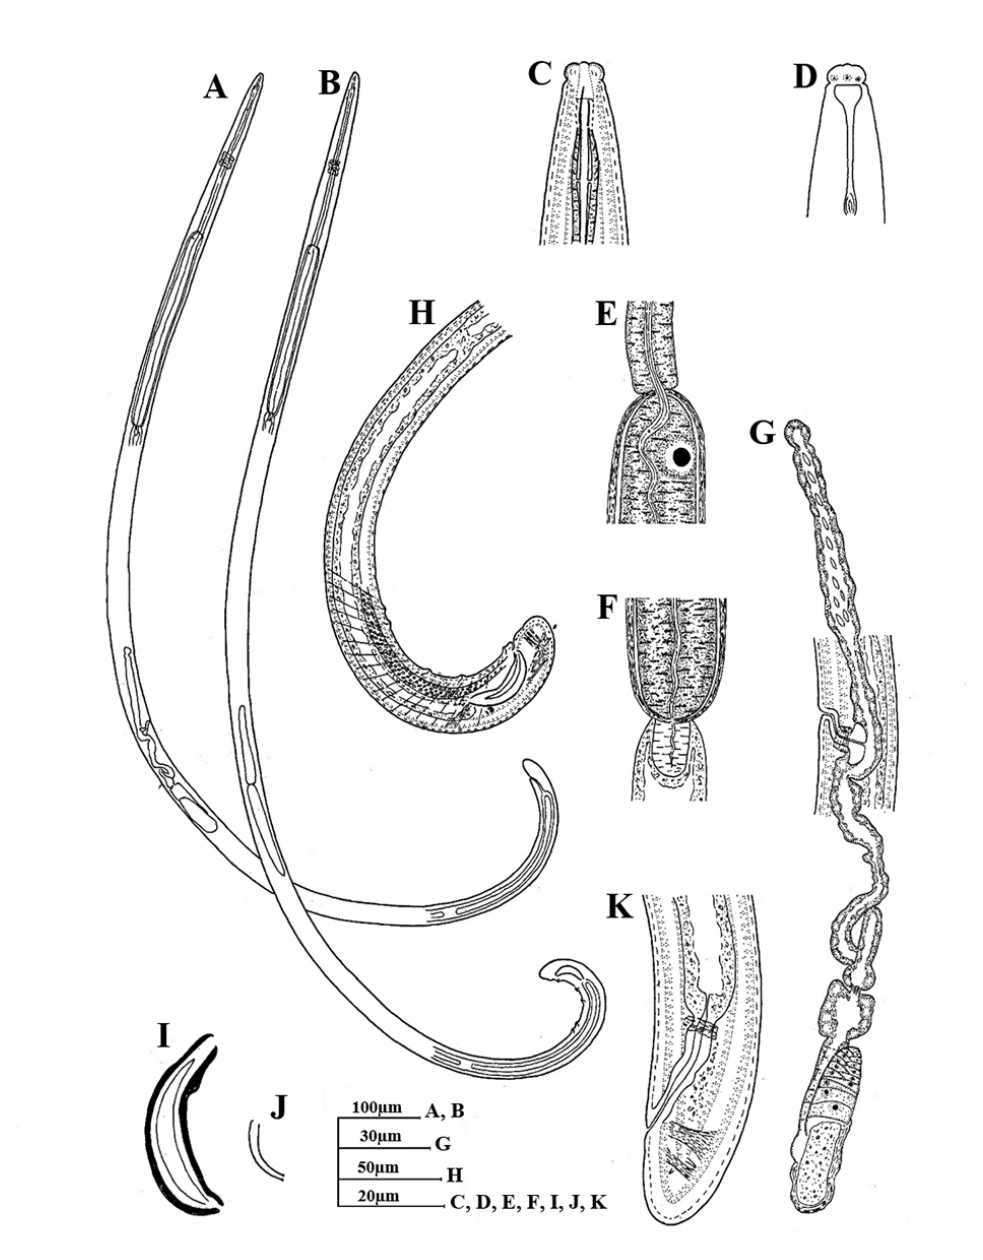
Fig. 9. Axonchium nilgiriense sp. nov. A , C – F , G , K . Paratype 4, ♀ (slide 4). B , H – J . Paratype 5, ♂ (slide 4). A . Entire female. B . Entire male. C . Anterior region. D . Anterior end showing amphid. E . Junction between anterior slender and posterior expanded part of pharynx. F . Cardia. G . Female genital system. H . Male posterior region. I . Spicule. J . Lateral guiding pieces. K . Female posterior